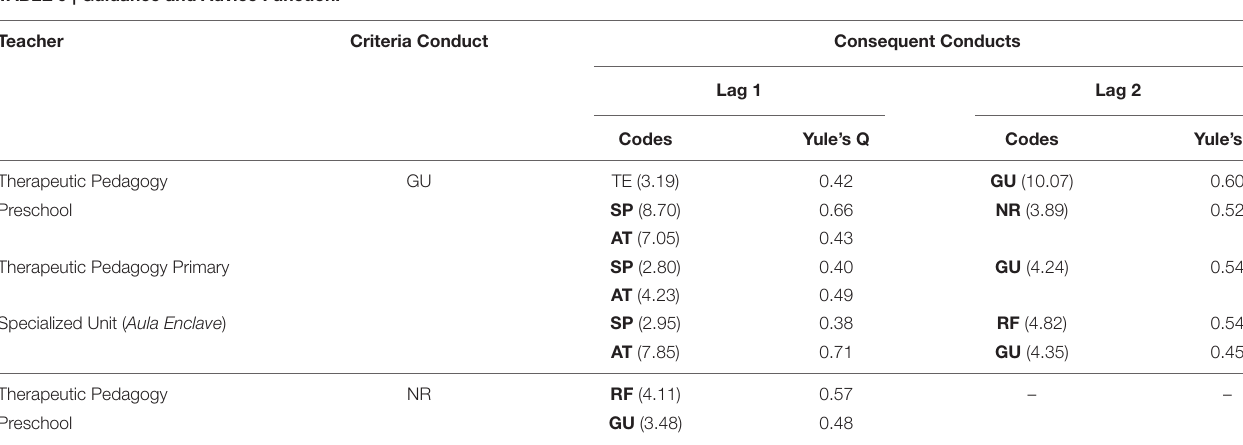
TABLE 9 | Guidance and Advice Function.